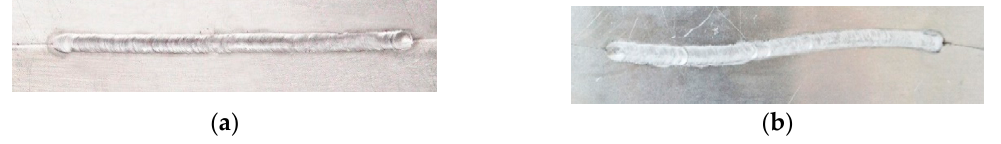
Figure 32. The welded workpiece with narrow butt. ( a ) The workpiece with the straight path; ( b ) The workpiece with the S-curve path.